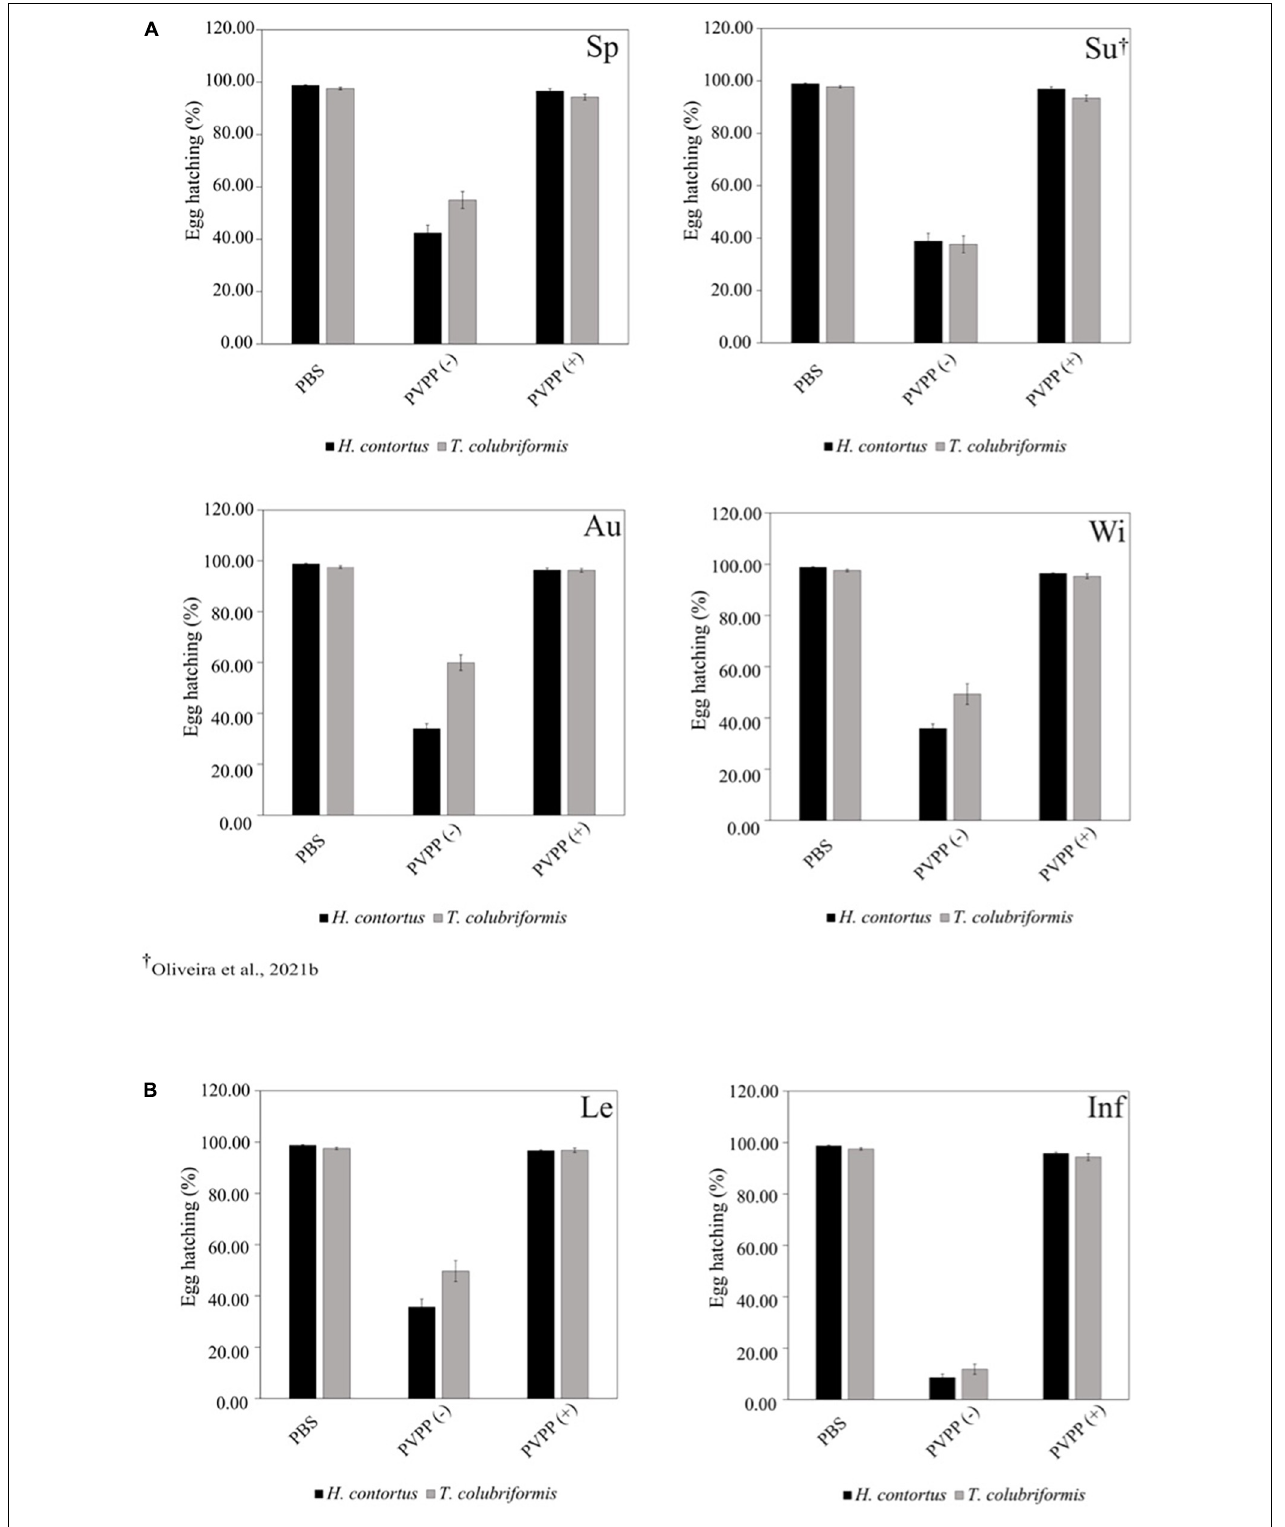
FIGURE 4 | Anthelmintic effects of Cladium mariscus (L.) Pohl (sawgrass) seasonal (A) and organ (B) extracts on EHIA for Haemonchus contortus and Trichostrongylus colubriformis at the concentration of 2,500 µ g mL − 1 , either treated [PVPP(+)] or not [PVPP(-)] with PVPP. Sp, spring; Su, summer; Au, autumn; Wi, winter; Le, leaves; Inf,